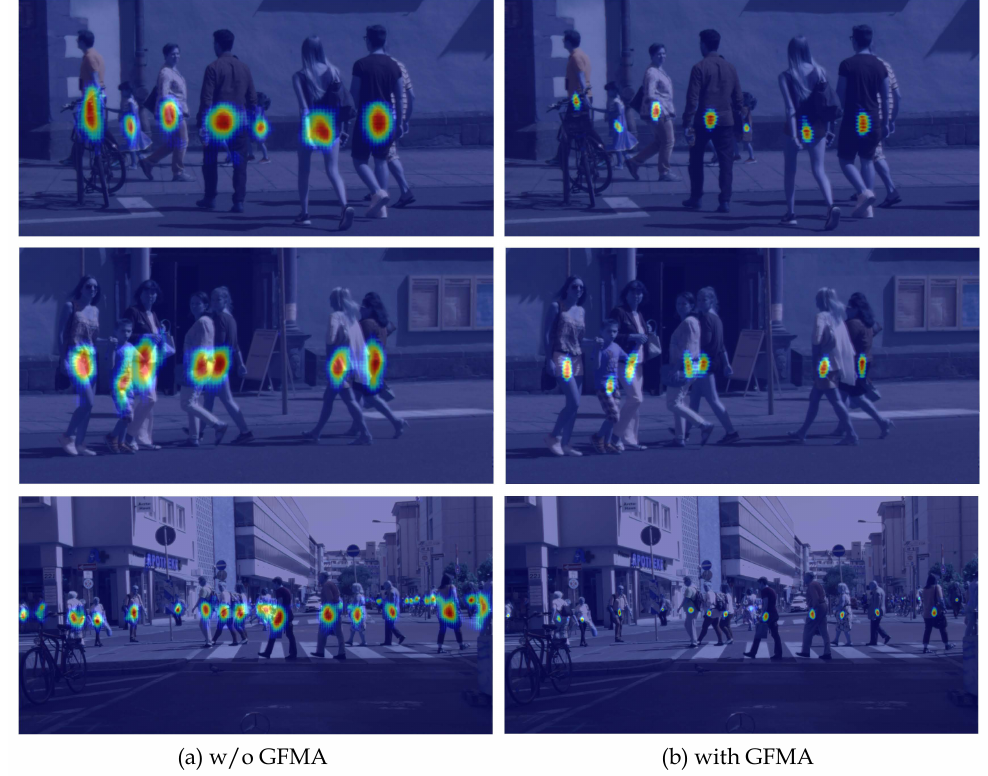
Figure 7. The gradient-weighted class activation maps with or without the GFMA